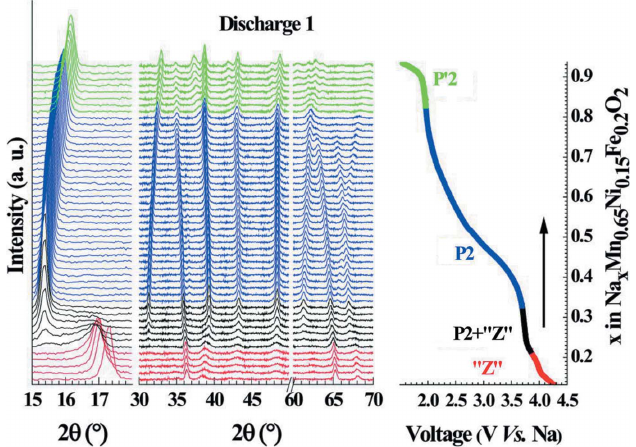
Figure 5 (Left) Operando laboratory-based X-ray powder diffraction data recorded during cycling of Na 0.67 [Mn 0.65 Ni 0.15 Fe 0.2 ]O 2 at a rate of C /20, along with (right) sodium content versus voltage for the first discharge. Colour codes relate to the electrochemical profile on the right. Reprinted with permission from Talaie et al. (2015). Published by the Royal Society of